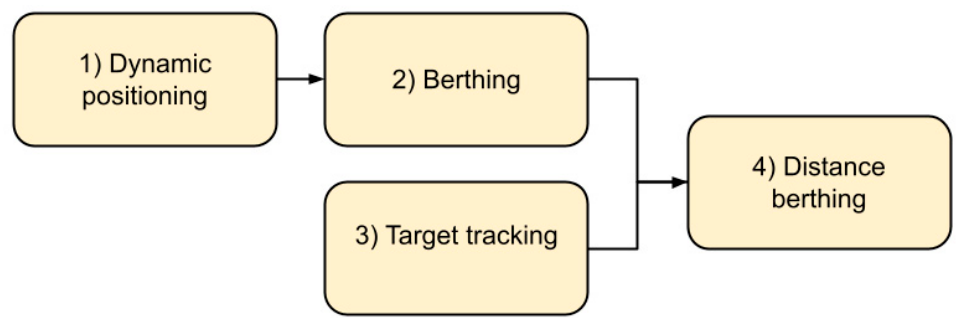
Figure A1. The different subtasks of the docking problem in relation to each other.